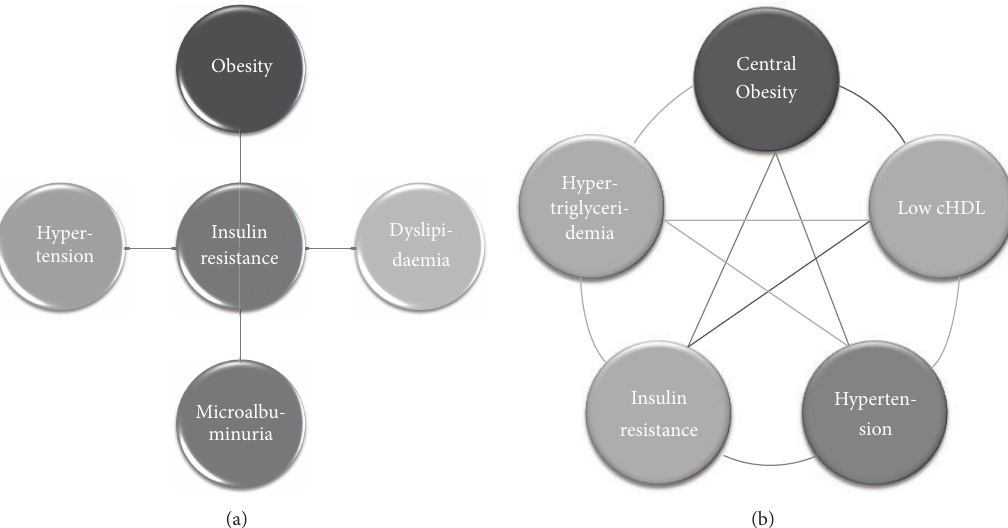
Figure 1: Two ways to conceptualize metabolic syndrome and the position hypertension and the other symptoms occupy. According to the WHO definition, insulin resistance is central to any other symptom (a). Others define metabolic syndrome as a cluster of symptoms where none has a central position